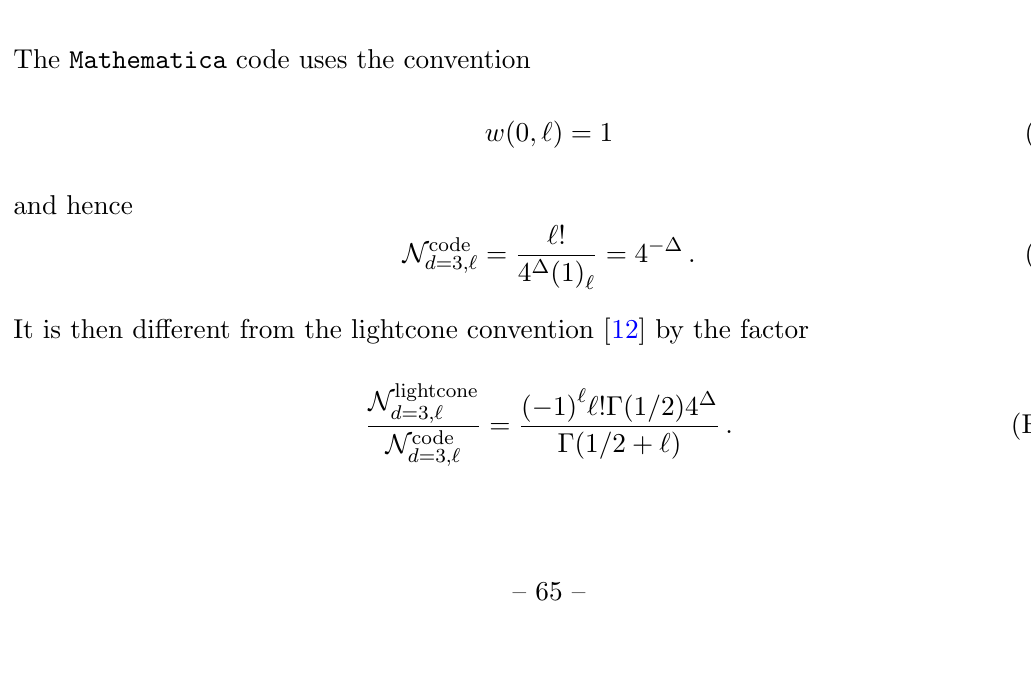
Figure 33 . The e(cid:11)ects of DTIs for OPEs of di(cid:11)erent low-lying double twists in the charge 1 [ (cid:30)t ] 1 even-spin